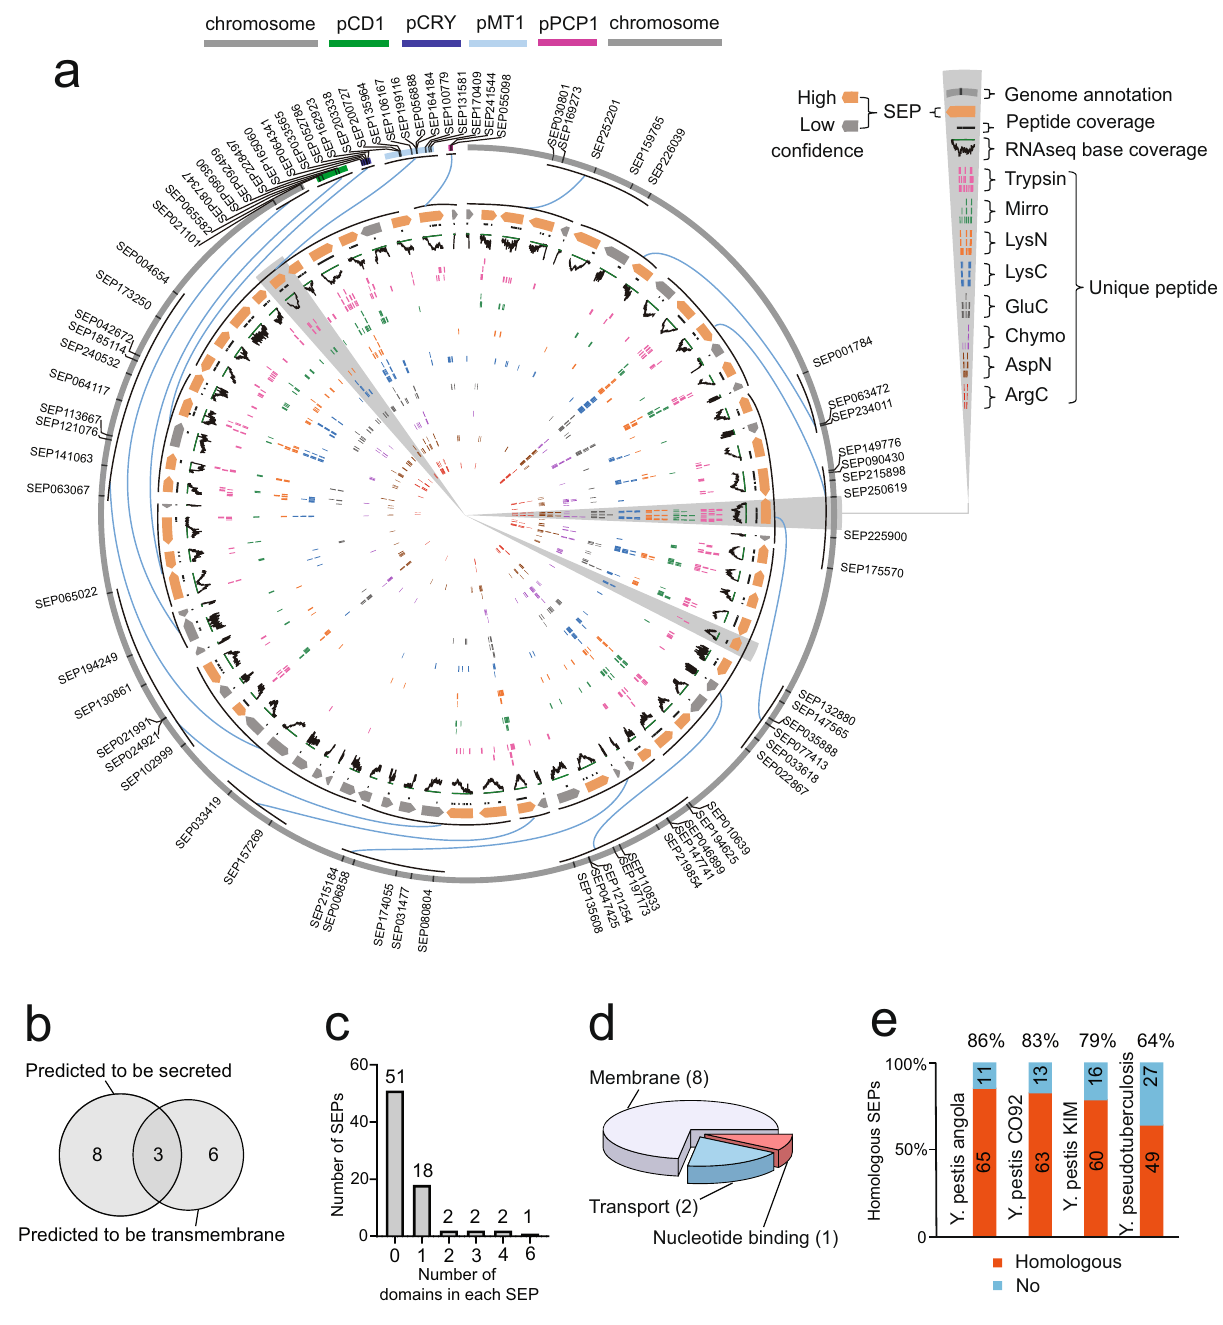
Fig. 2 The atlas of identi fi ed SEPome. a Circos plot showing the genome, transcription and protein information of the identi fi ed 76 SEPs. The Circos labels were listed in the upper right of the panel. Brie fl y, the information of unique peptides, RNA-seq base coverage, and genome annotation were shown from inside to outside rings. The outermost ring represents the chromosome and four plasmids (information labeled in the color bands at the top of the panel). Unique peptides resulting from eight proteases were, respectively, in eight colors. Each unique peptide maps the amino acid sequence position on the SEPs. Identi fi cations with one unique peptide after manual curation represent low con fi dence, and greater than one unique peptide is of high con fi dence. The RNA-seq reads coverage were generated by alignment of reads to nucleotide position. Refer to Supplementary Data 1 for the details of the SEPs. b Venn diagram showing secreted and transmembrane proteins as predicted by SignalP and TMHMM among the 76 SEPs. c Distribution of domain-containing SEPs as predicted by Pfam among the 76 SEPs. d Functional inference among the 76 SEPs as determined using BLASTP against the SEP dataset from a previous report 10 . e Homologous analysis of the 76 SEPs using tblastn in human-virulent bacterial strains. The homologous SEPs are selected by identities >90% and e value <1e − 3 . The detailed results of the bioinformatic analysis are listed in Supplementary Data 3. Mirror mirror